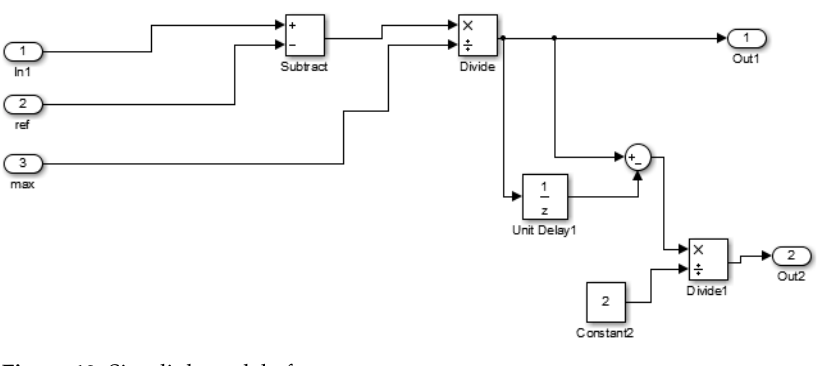
Figure 10. Simulink model of comparator.